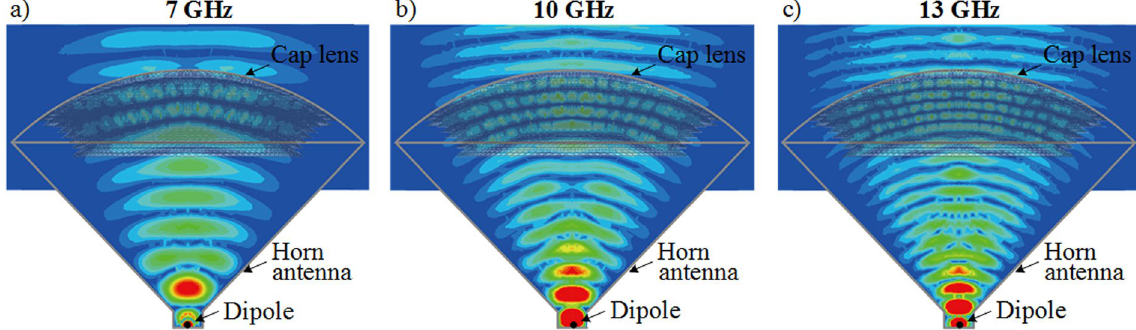
Figure 7. Simulated electric near field distributions of 3D discrete lens in the x-y plane at ( a ) 7 GHz, ( b ) 10 GHz and ( c ) 13